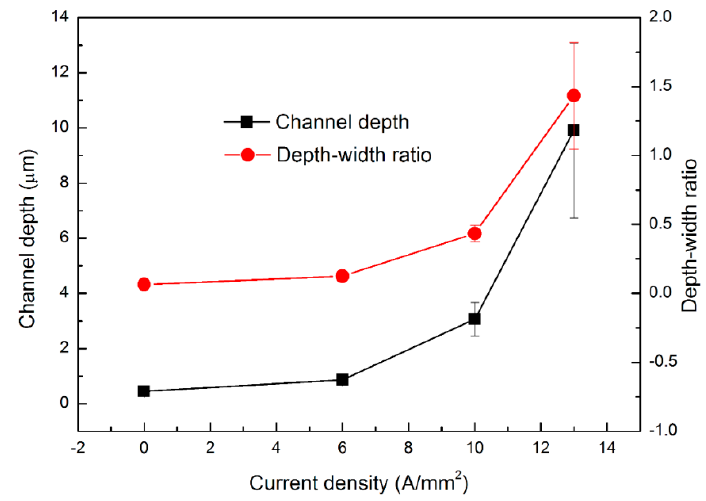
Figure 7. Variations in channel depth and depth–width ratio with respect to different current densities.